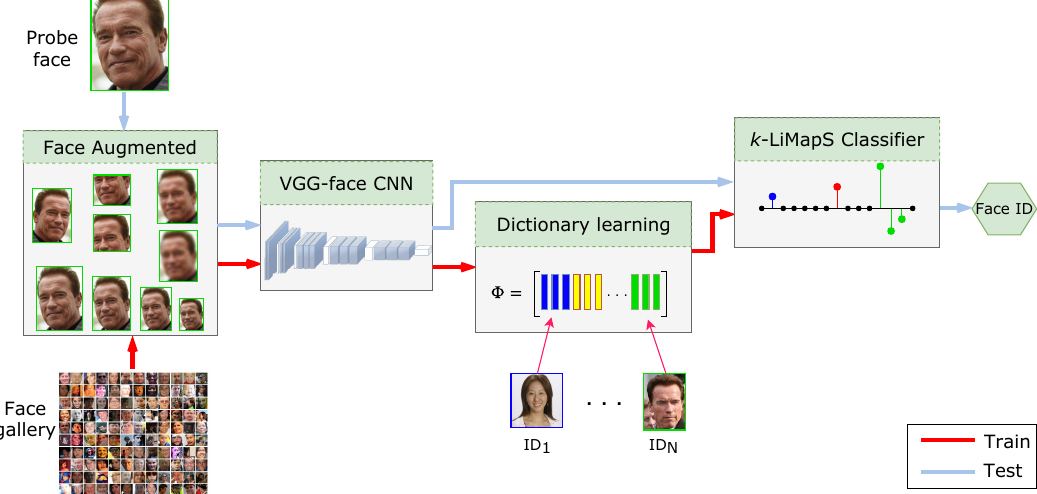
Figure 1. Classification process diagram. First stage: gallery and probe image augmentation. Second stage: deep-feature extraction via VGG-face net. Third stage: sparsity-driven sub-dictionary learning. Fourth stage: identity characterization by k -L I M AP S and face identity